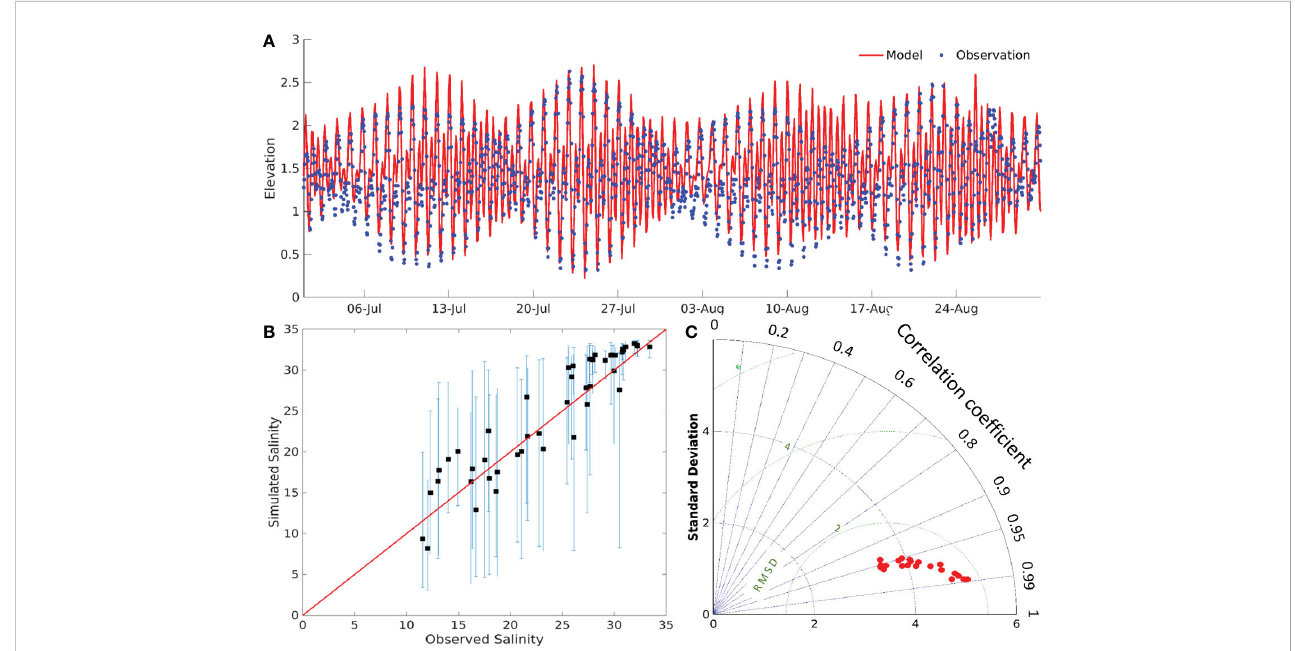
FIGURE 2 Comparison between model result and fi eld data of (A) water level at the gauge station Waglan Island and (B) surface salinity collected during a research survey in July 2017 by Yu et al. (2021). In addition, simulated temporal variation of surface salinity within a tidal cycle at each measuring station is indicated by the bar crossing the measured value. Location of the stations is shown in Figure 1B. (C) Taylor diagram showing the standard deviation, the correlation coef fi cient, and the RMSE of simulated surface temperature against fi eld data at 23 stations. Location of the stations is shown in Figure 1B by red